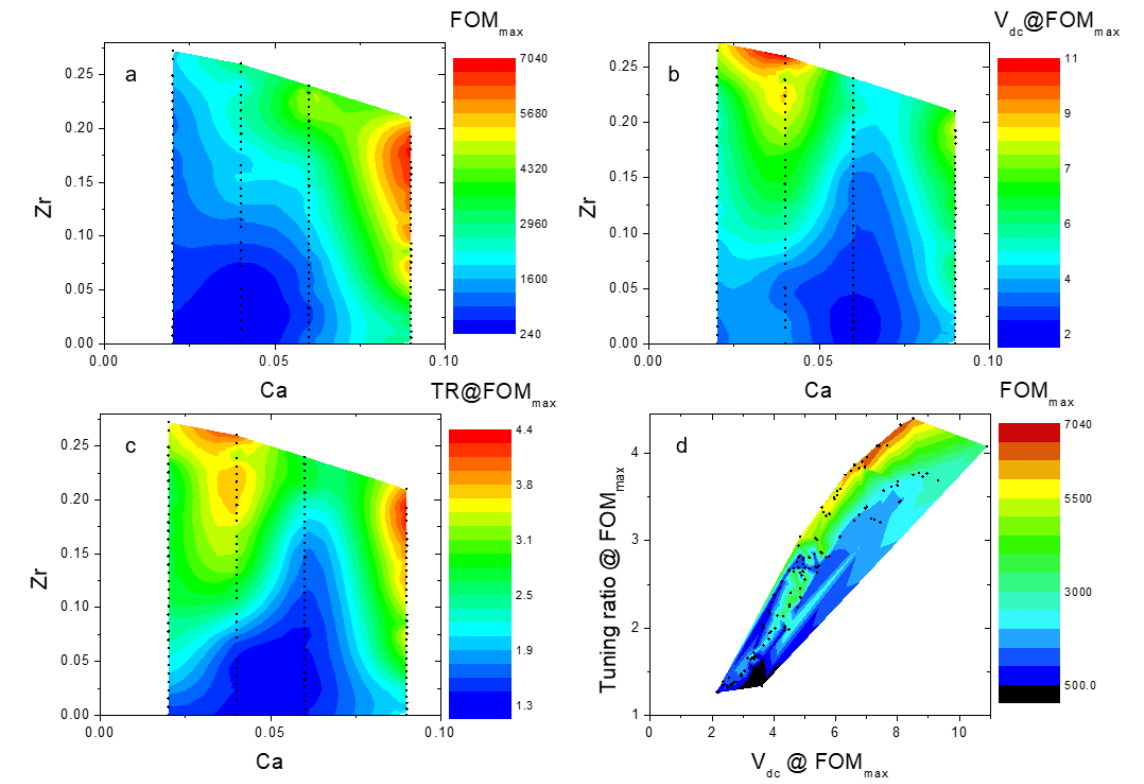
Figure 4. Maps of FOM max ( a ), V dc at FOM max ( b ) and TR at FOM max ( c ) for the 2%, 4%, 6%, 9% Ca libraries vs. Ca and Zr amount. ( d ) Map of FOM max vs. TR at FOM max and V dc at FOM max for the same capacitors. Black dots are the actual data points.